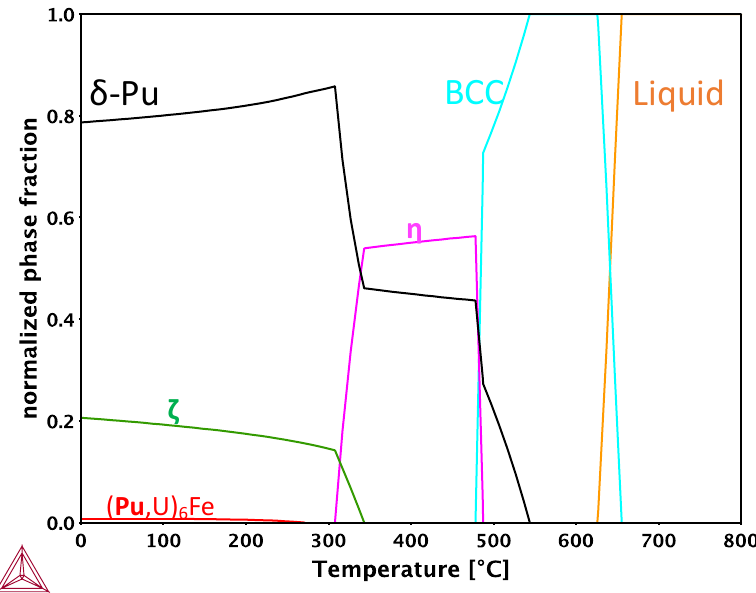
Figure 12. Property diagram of Pu 92.9 U 5 -Ga 2 -Fe 0.1 (at. %) calculated using the present CALPHAD database.